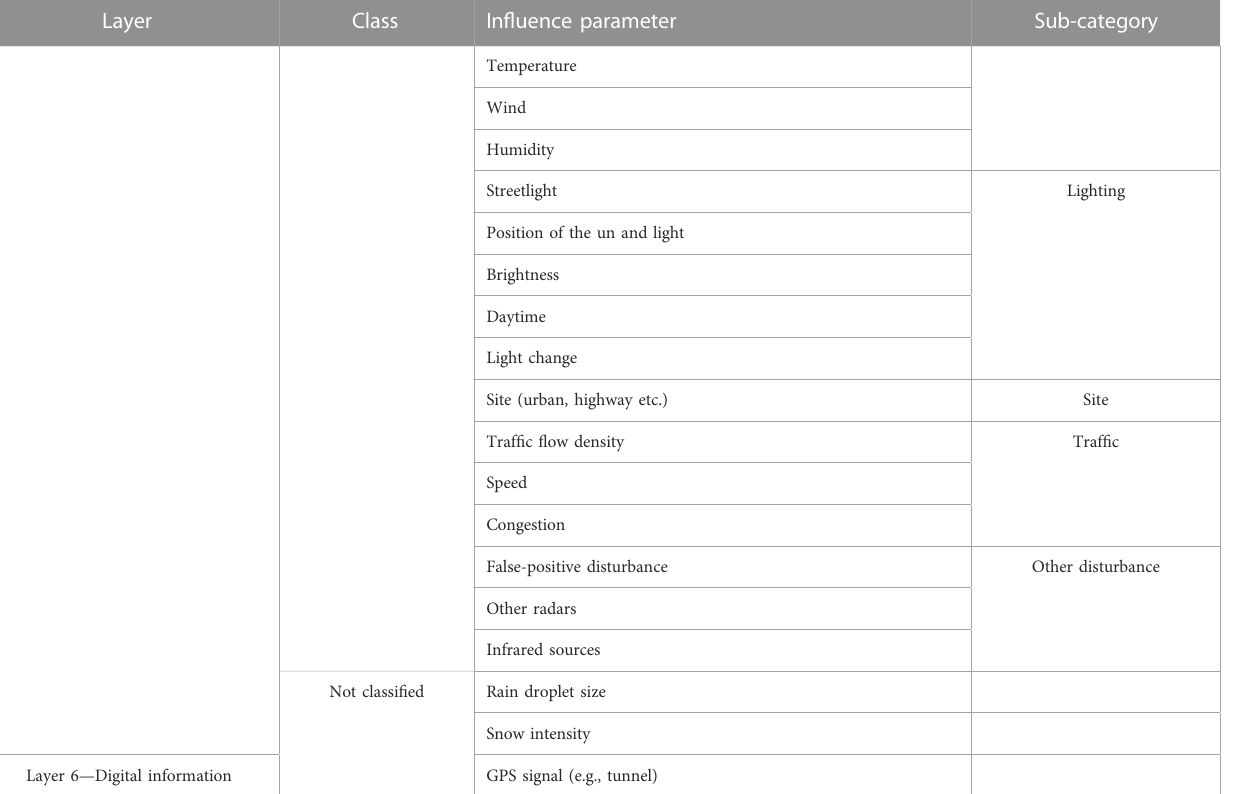
Table 5. The clustering result obtained by applying K-prototypes with a cluster number of three was accepted.